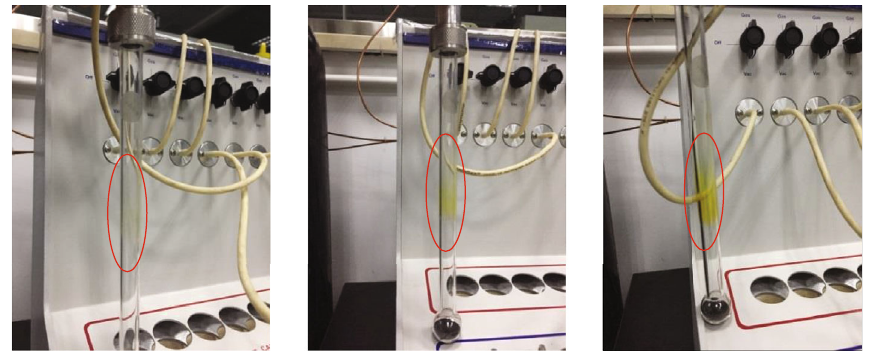
Figure 12: The steam condensate from the volatiles of the coal under various pretreatment temperatures (240 ° C, 270 ° C, and 300 ° C, respectively, from the left to